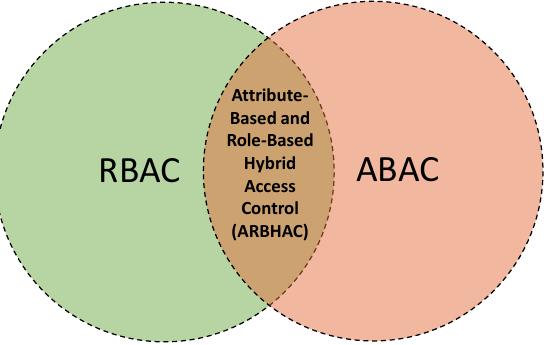
Figure 5. A conceptual representation of the proposed HyBAC model of [75].